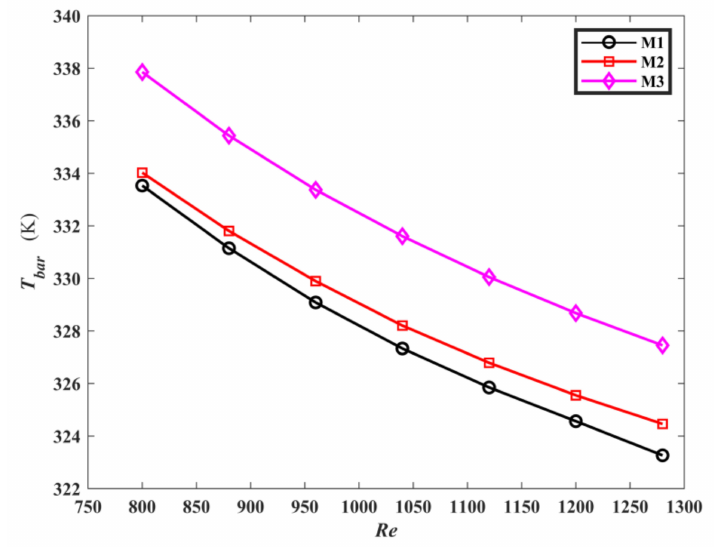
Figure 9. The T bar of the three mini-channels varies with Re .